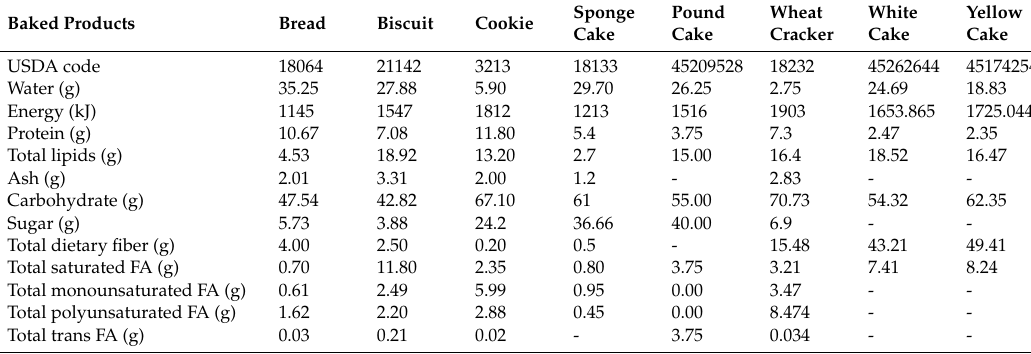
Table 6. Nutritional information of baked goods by US Department of Agriculture (USDA)